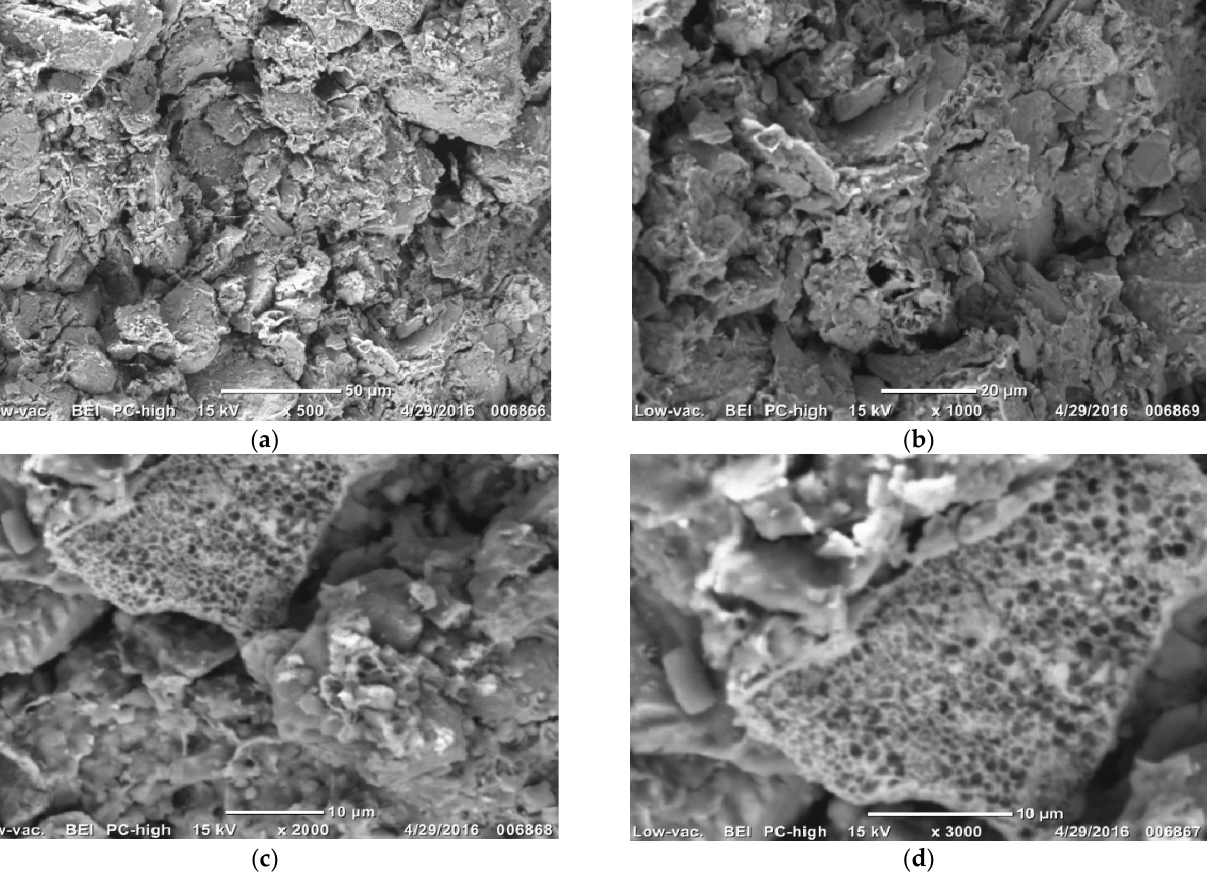
Figure 9. Microstructure of the fired ceramic sample with loam of the Ukrainian deposit. Magnification: ( a ) ×500, ( b ) ×1000, ( c ) ×2000, ( d ) ×3000.